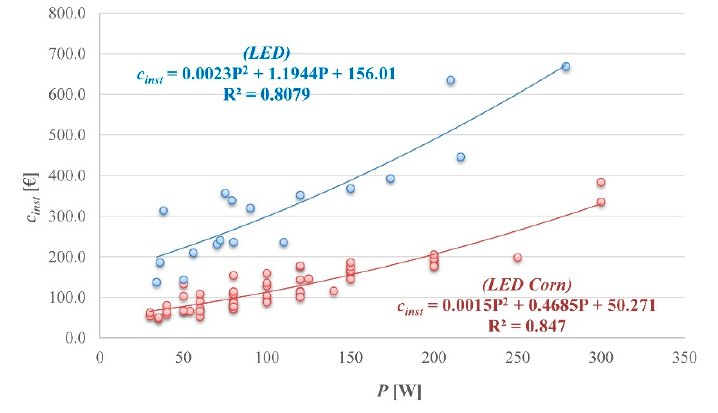
Figure 5. The price of LED corn bulbs and LED street lighting luminaires.